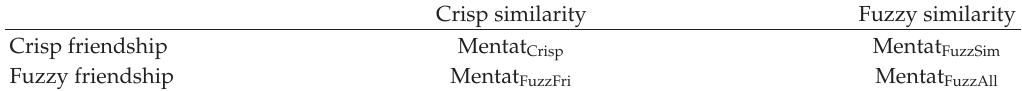
Table 1: Four di ff erent implementations of Mentat.